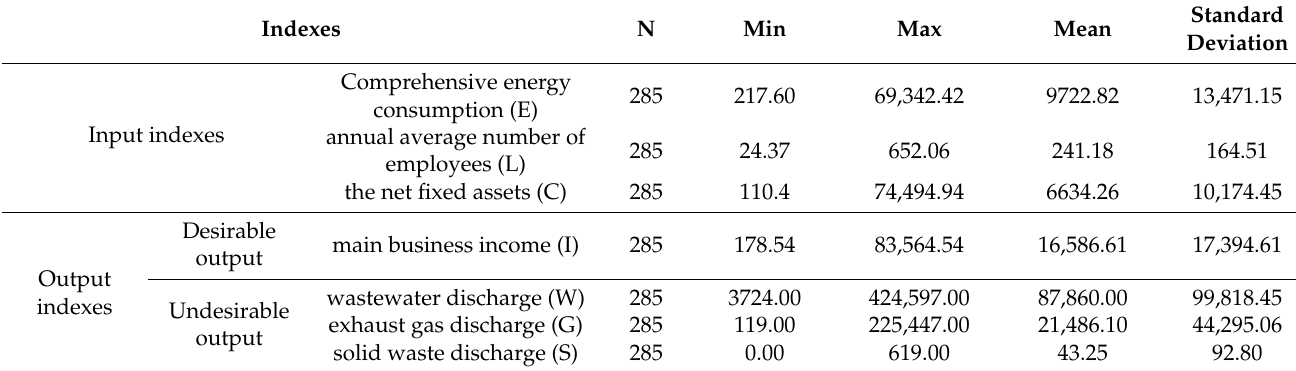
Table 1. Descriptive statistics of environmental efficiency evaluation indicators.